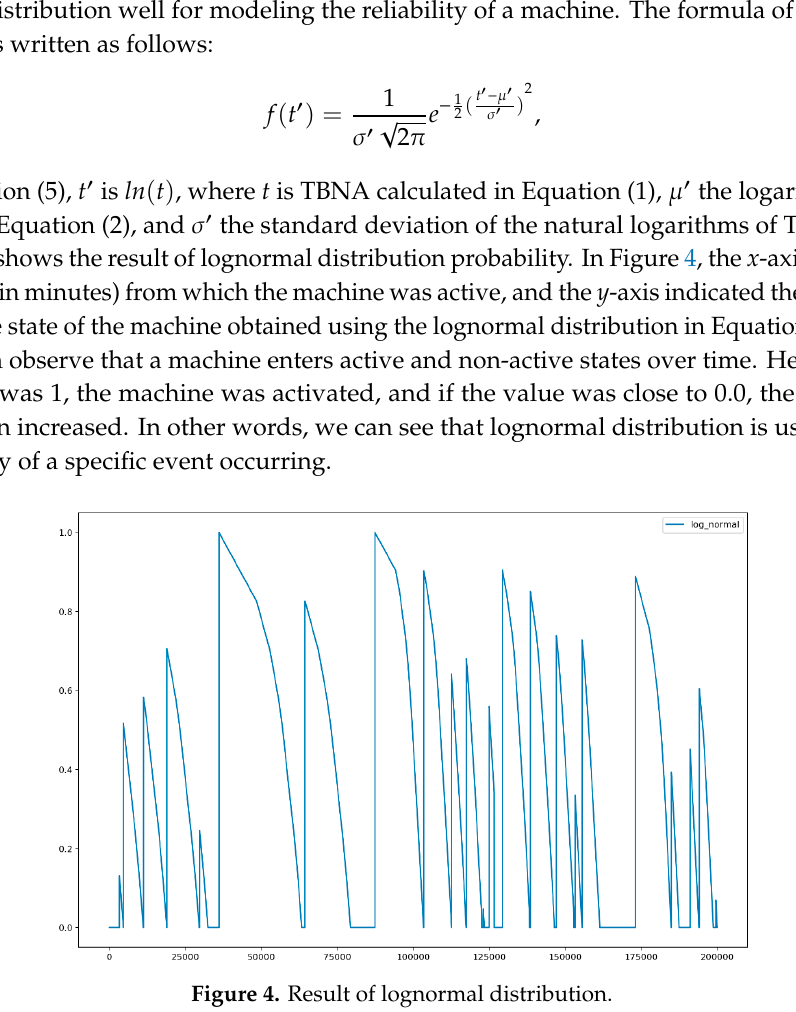
Figure 4. Result of lognormal distribution.